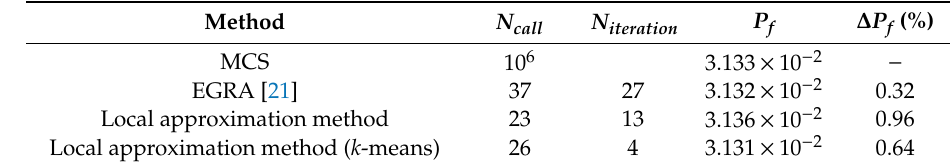
Table 1. Results of the reliability analysis of Example 1.